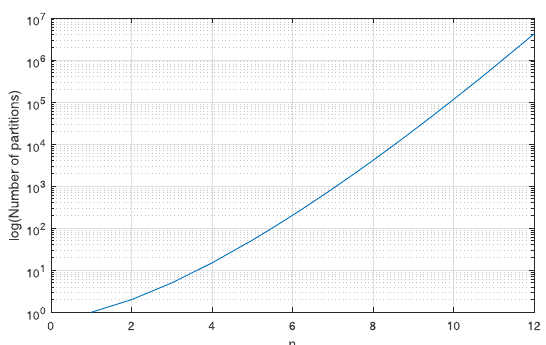
Fig. 2 Number of partitions for n-element set